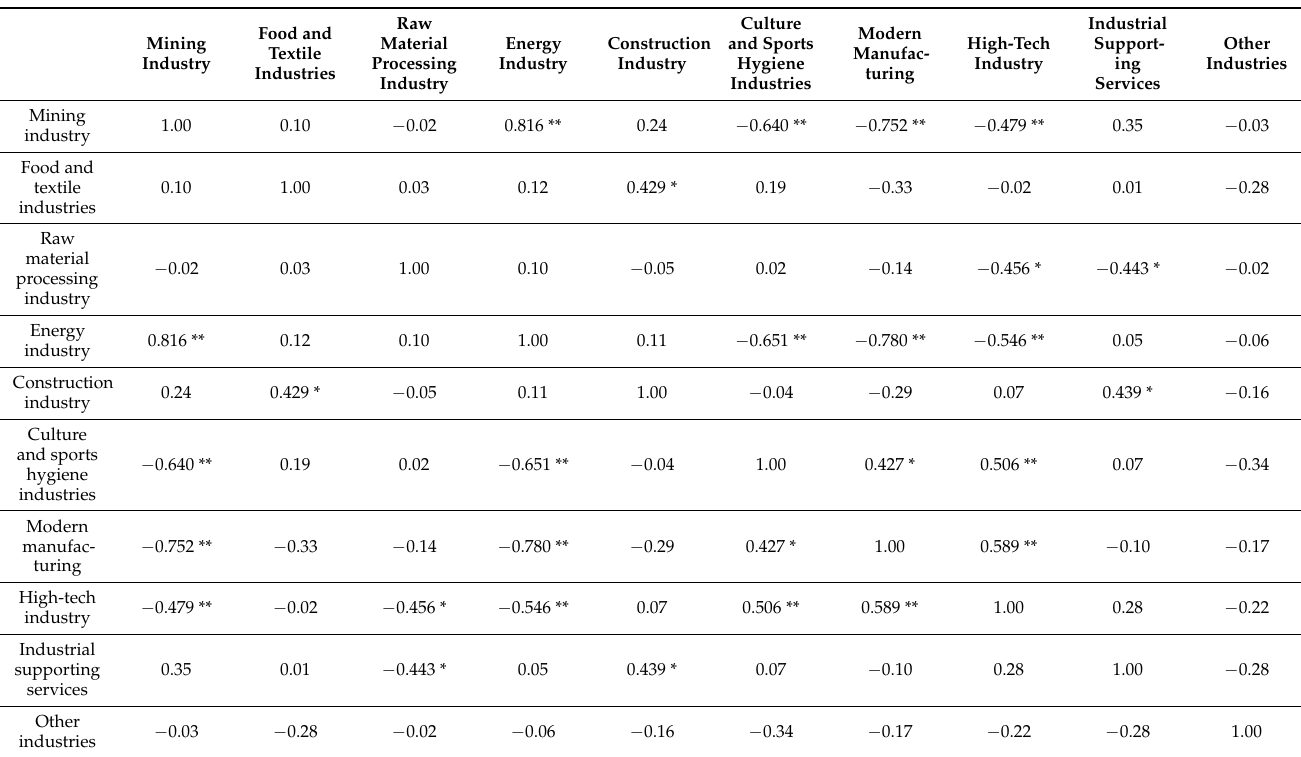
Table 2. Spearman correlation